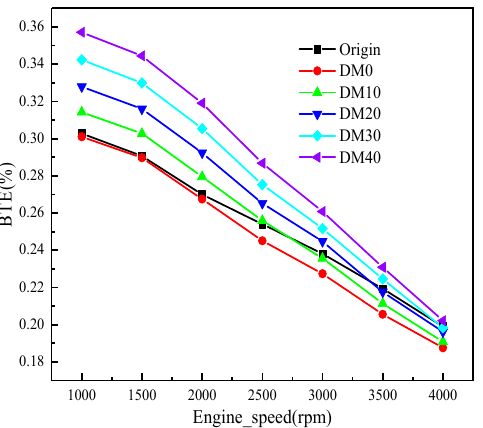
Figure 8. Effect of different ratios of methanol-diesel mixtures on BTE at different speed.